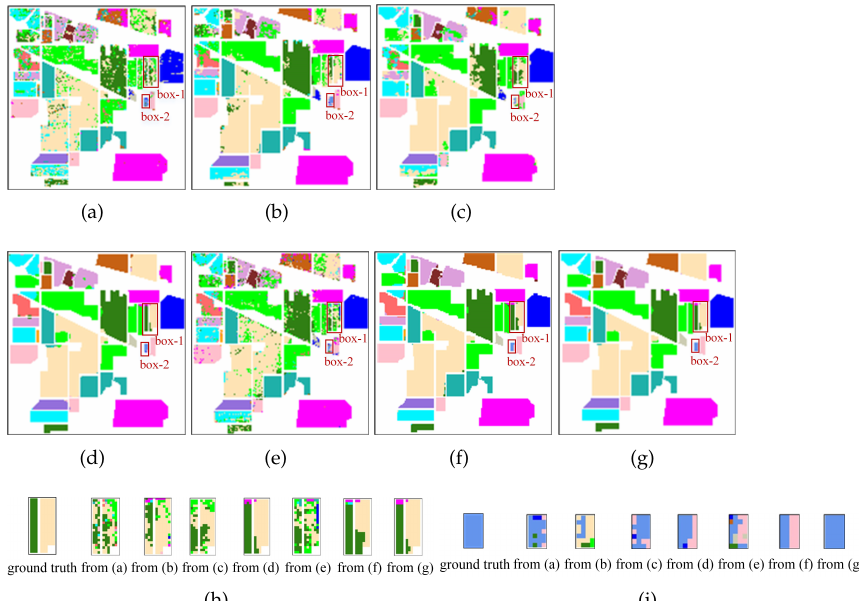
Figure 12. The classification maps of the IP dataset. ( a ) SVM. ( b ) 2D-CNN. ( c ) 3D-CNN. ( d ) HybridSN.